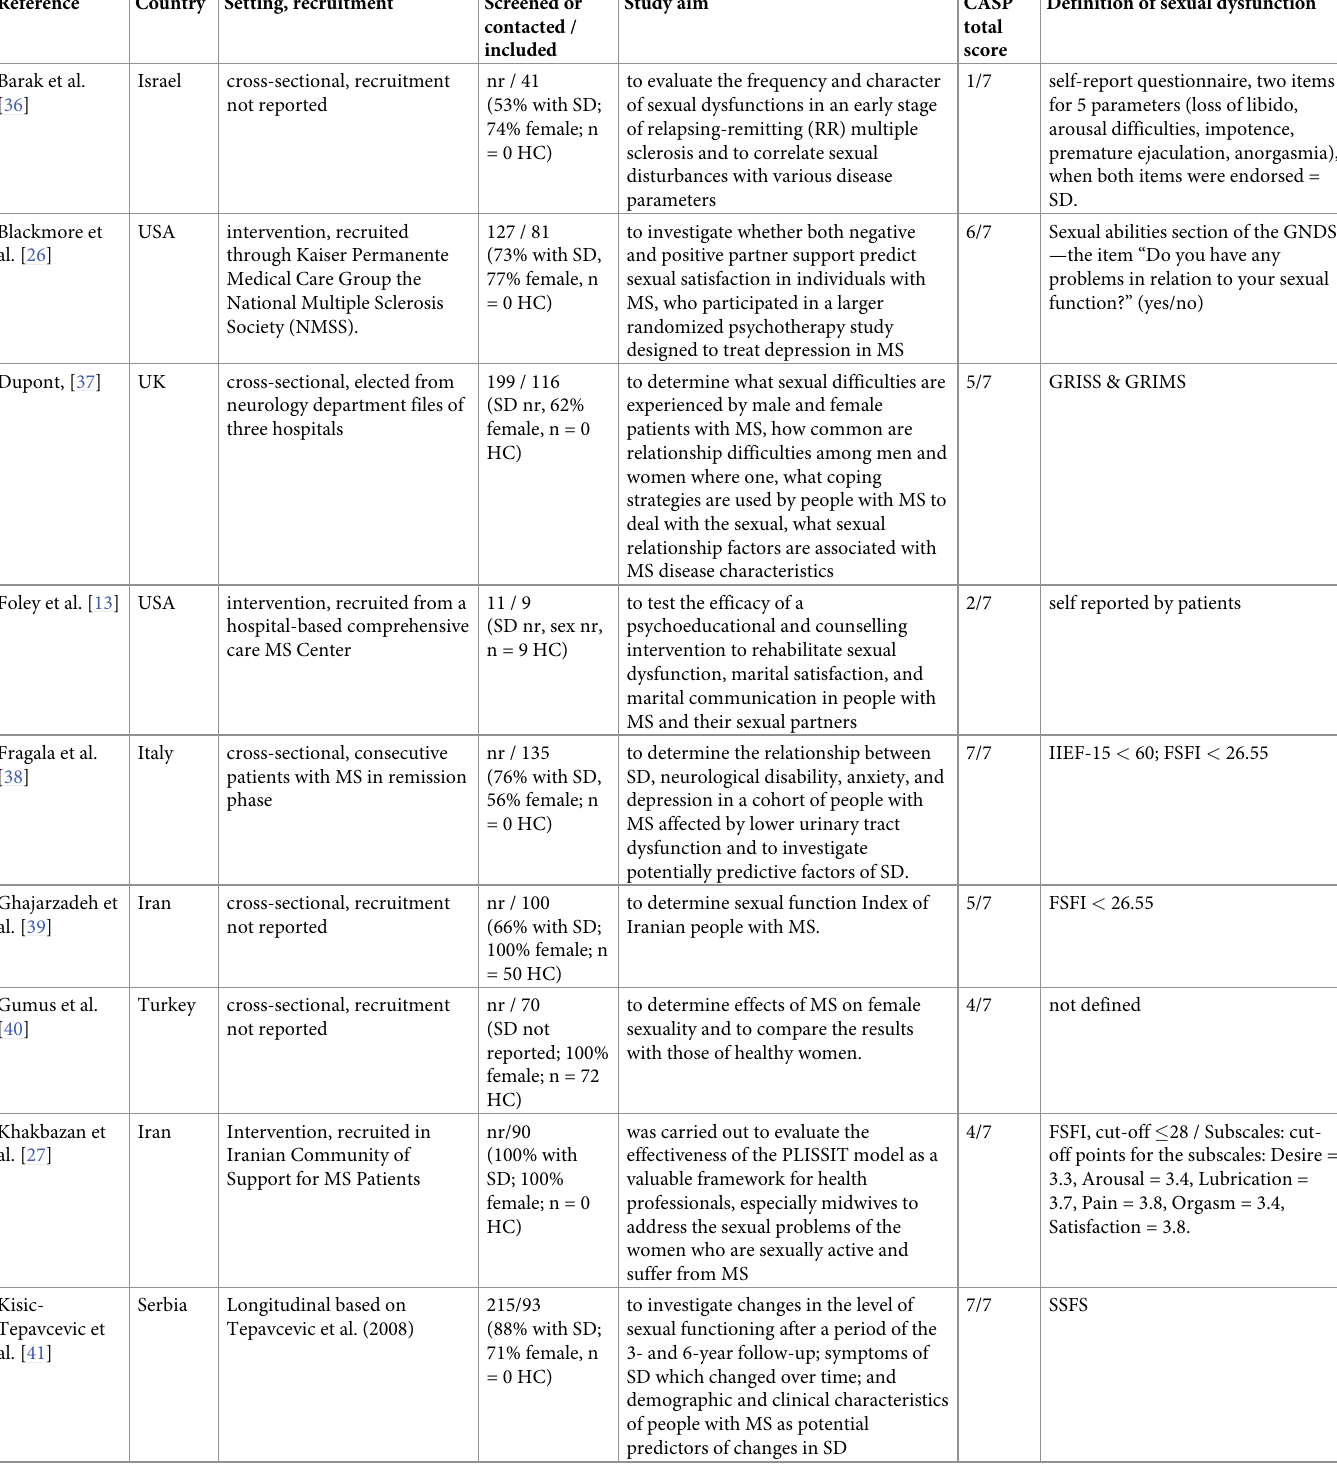
Table 2. Overview of included